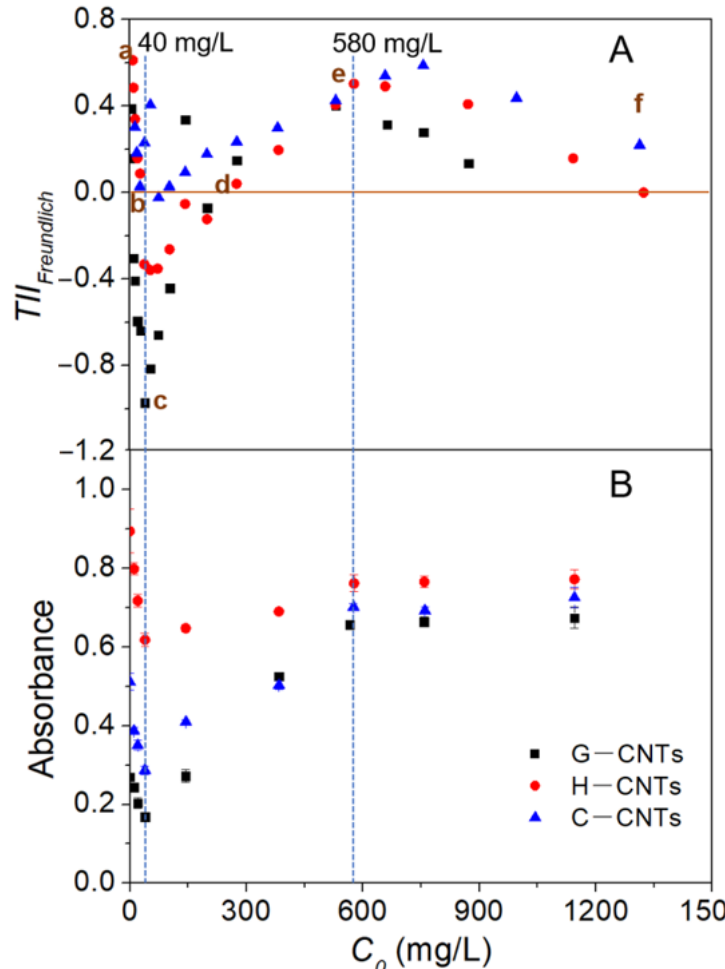
Figure 2. Value of the Freundlich form of TII versus a wide range of initial concentration of nitrobenzene by three functionalized MWCNTs ( A ); and absorbance at 800 nm of three functionalized CNTs with a wide range of initial concentration of nitrobenzene after shaking for 72 h and settling down for 5 min ( B ). Error bars represent the standard deviation of three replicates. If error bars are not evident, they are obscured by the points.